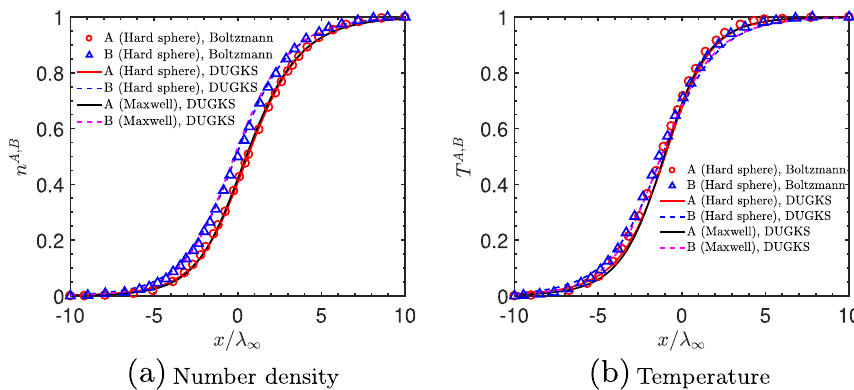
Fig. 8 Shock structure of different molecular models with Ma − = 1.5 , m B ∕ m A = 0.5 , and 𝜒 A = 0.1